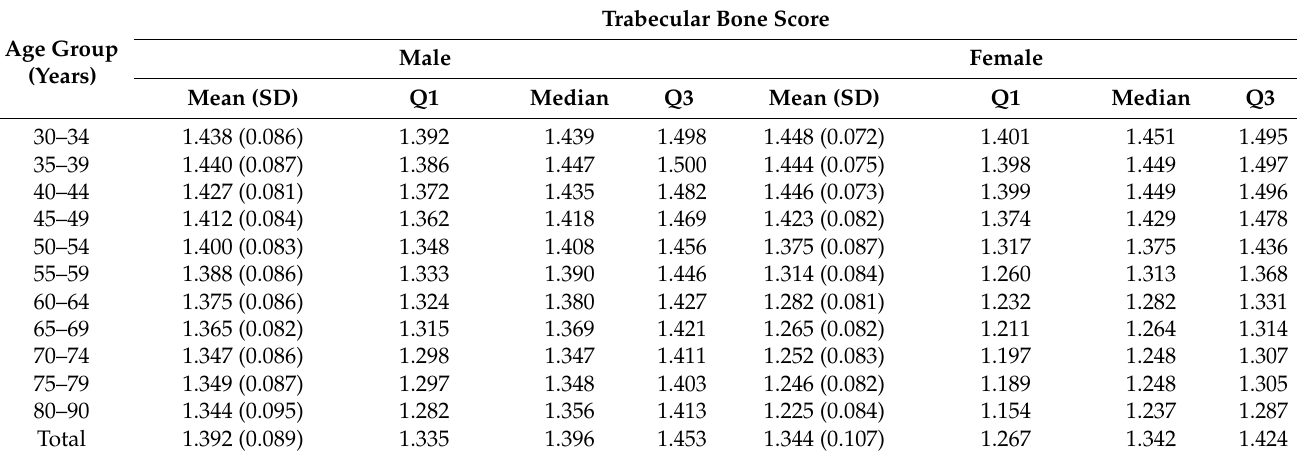
Table 3. Age-specific trabecular bone score for Taiwanese men and women.